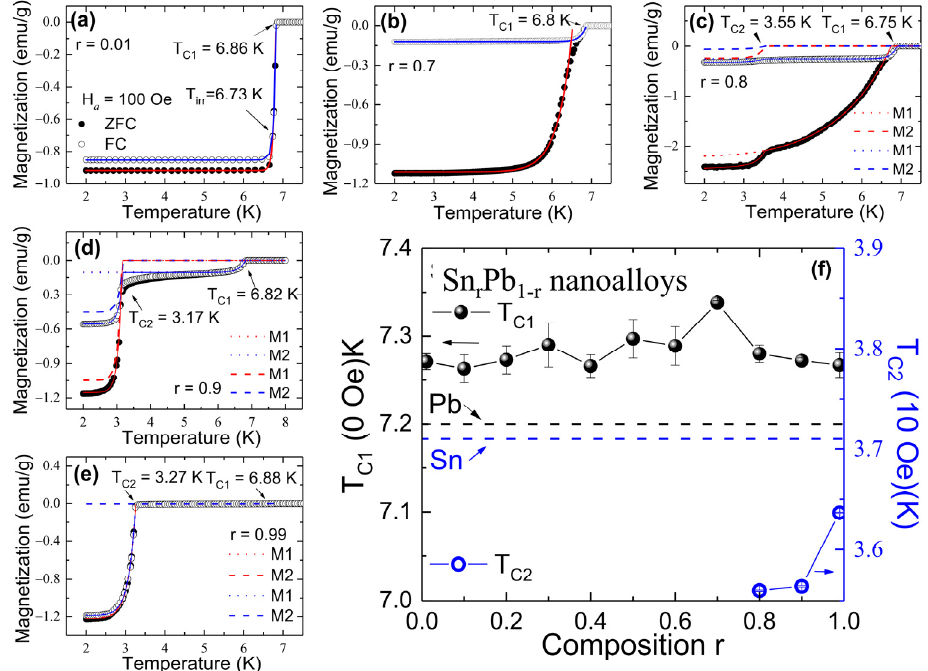
Figure 4. ( a – e ) temperature dependence of magnetization measured between 2 to 8 K in an external magnetic field of H a = 100 Oe in the ZFC and FC modes for r = 0.01, 0.7, 0.8, 0.9, and 0.99 nanoalloys. The red and blue solid curve presents the fitted curve of the modified London expression to the data; ( f ) fitted value of transition temperature T C1 (black sphere, see Section 3.5) and T C2 (blue circle, measured at 10 Oe) as a function of the initial composition. The horizontal dashed lines represent the reported values of T C from bulk Pb and Sn.